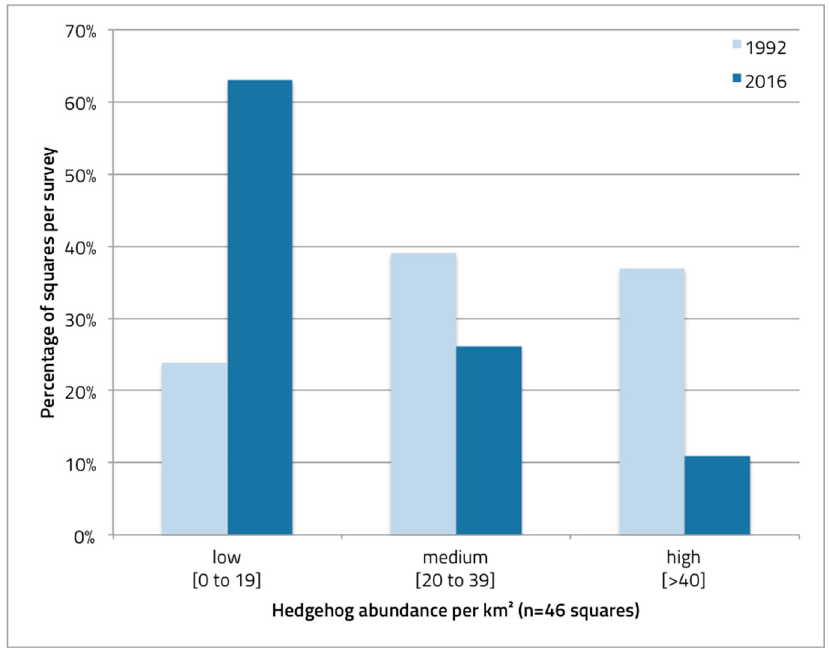
Figure 4. Proportion of km-squares per survey period (past in light blue; recent in dark blue) with low, medium, and high hedgehog abundance per km 2 .